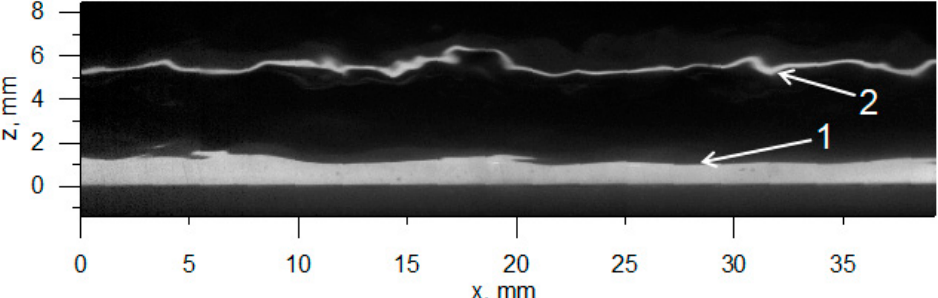
Figure 9. Raw PLIF-image of a falling film flow in a vertical 32.4 mm pipe; taken from the experi- mental data set [52]. (1) PLIF-image of liquid film (both true and false image, see below); (2) “Ghost” image of the film seen through the pipe wall.